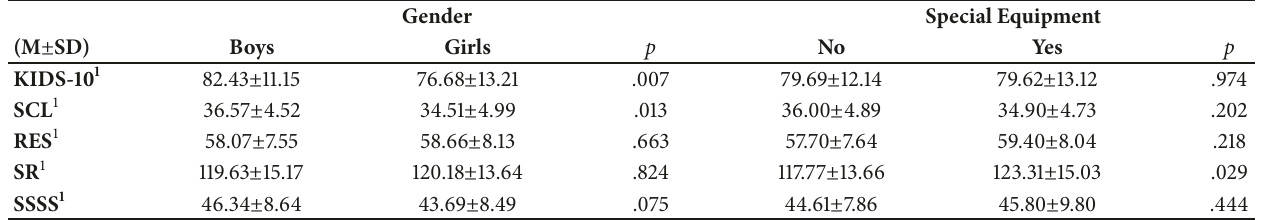
Table 4: Differences between gender (boys/girls) and using special equipment (yes/no) for all psychosocial variables. Gender Special